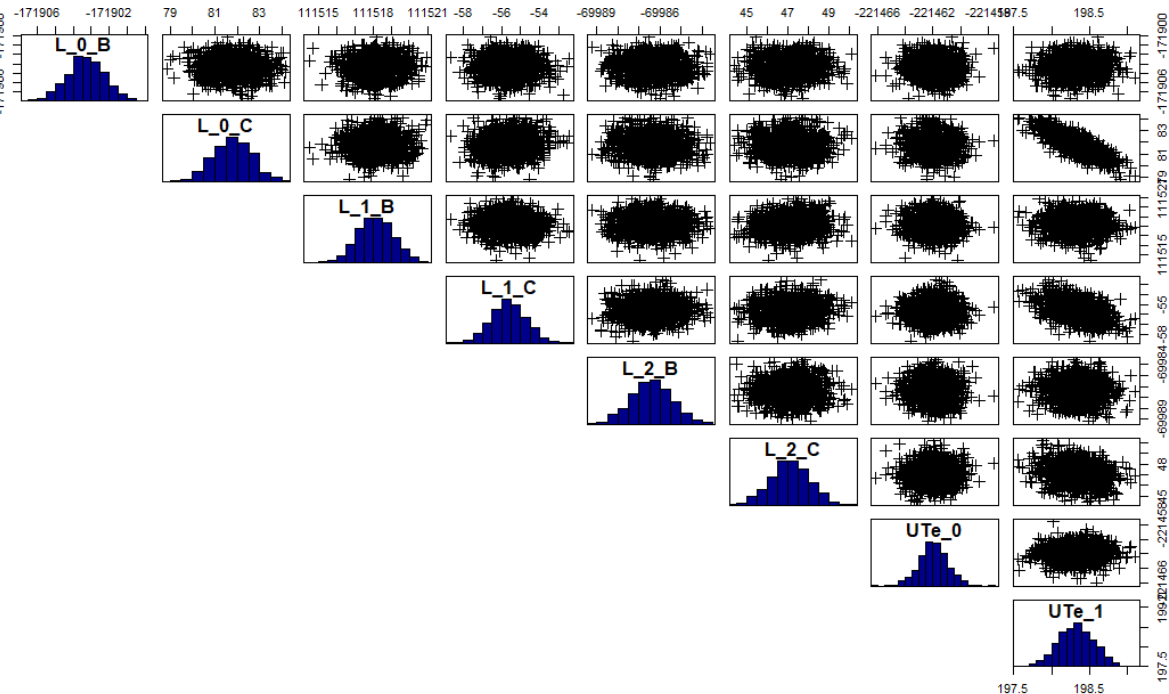
Figure 7. Parameter posterior probability distributions and correlations matrix plot for the liquid phase on UTe–Te side and UTe. The posterior correlation values can be found in Appendix